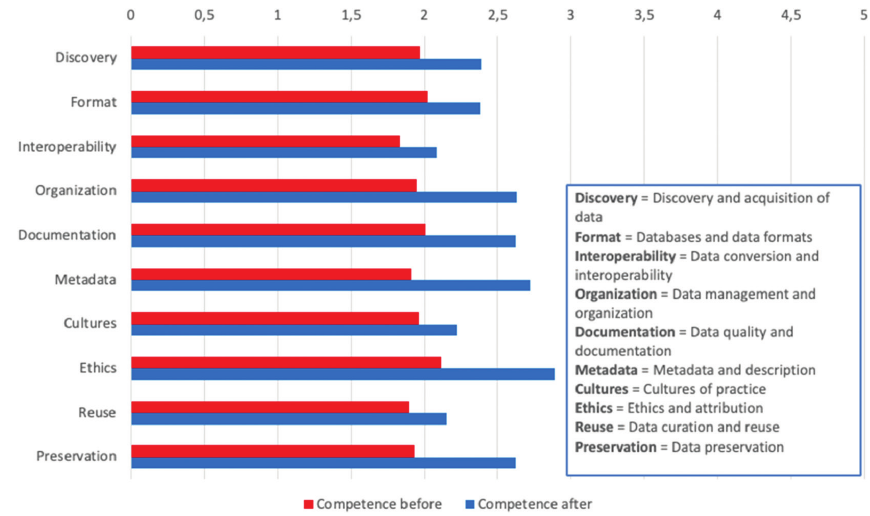
Fig. 6: Respondents’ median self-ratings of their competencies before and after the BRDM 2019